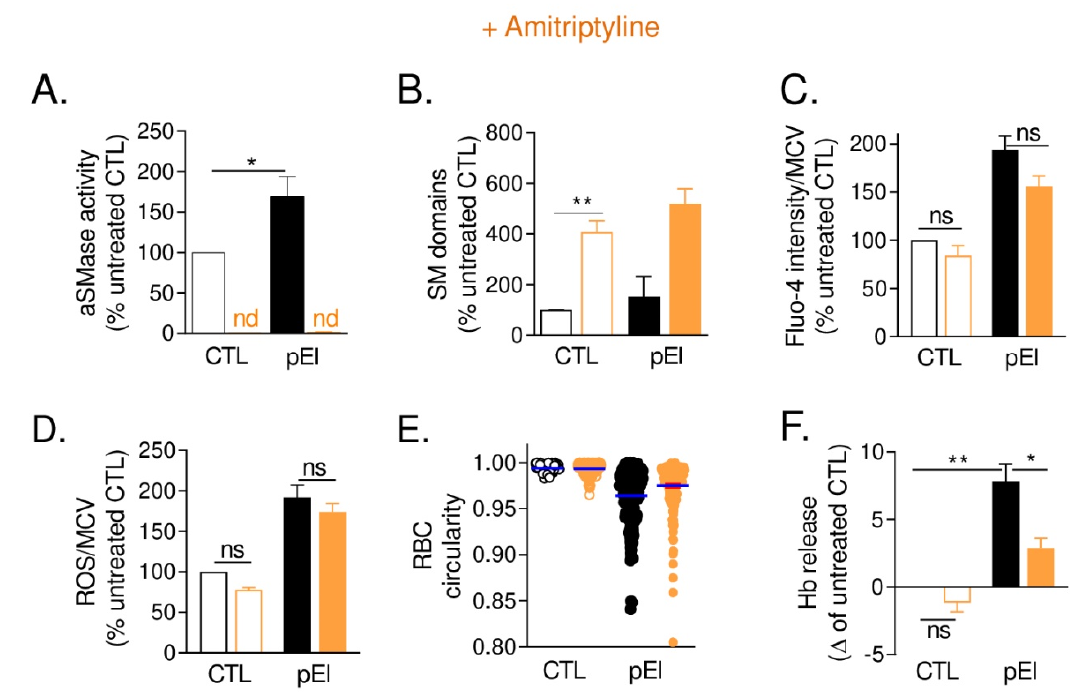
Figure 8. Inhibition of the aSMase activity by amitriptyline in pEl modulated sphingomyelin-enriched domains and partially restored RBC morphology and functionality. Whole blood was incubated with the aSMase inhibitor, amitriptyline (AMI), and assessed for aSMase activity ( A ) while RBCs were washed and tested for sphingomyelin-enriched domain abundance ( B ), Ca 2 + and ROS accumulation ( C , D ), circularity ( E ) and fragility ( F ). ( A ) aSMase activity determined in plasma isolated by Ficoll separation. Data are means ± SEM of 4 independent experiments. Nd, non detectable. Mann-Whitney test. ( B ) Abundance of sphingomyelin-enriched domains determined as in Figure 3E. Data are means ± SD / SEM of 2–4 independent experiments. Paired t test. ( C , D ) Intracellular Ca 2 + and ROS contents measured as in Figure 5B,G. Data are means ± SEM of 3–4 independent experiments. Wilcoxon matched-pairs signed rank tests. ( E ) RBC circularity measured as in Figure S2. One representative experiment out of 4 independent experiments; unpaired t tests: CTL vs. CTL + AMI, *; pEl vs. pEl + AMI, **. ( F ) RBC fragility evaluated in isotonic medium as in Figure 5C. Data are expressed as delta of Hb release by AMI-treated and untreated RBCs (means ± SEM of 6 independent experiments). Mann-Whitney test for comparison of CTL vs. pEl and Wilcoxon matched-pairs signed rank test for the effect of AMI. ns, not significant; *, p < 0.05; **, p < 0.01.